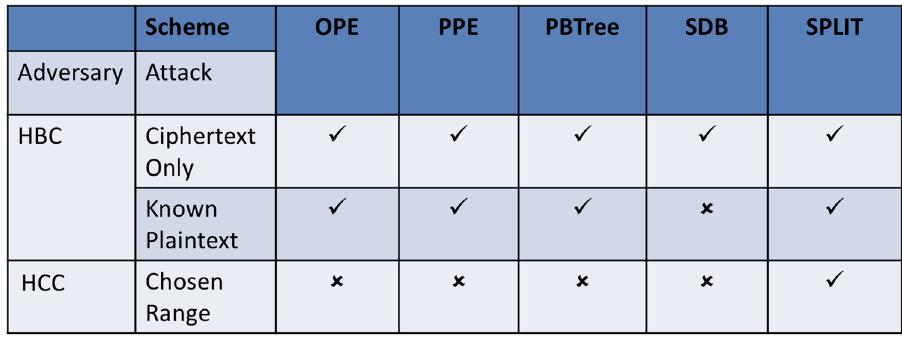
Fig. 11 Comparison of SPLIT with prior